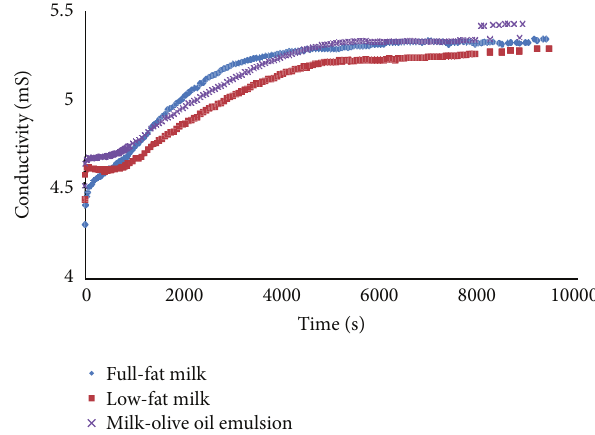
Figure 2: Conductivity evolution versus time of various renneted milk